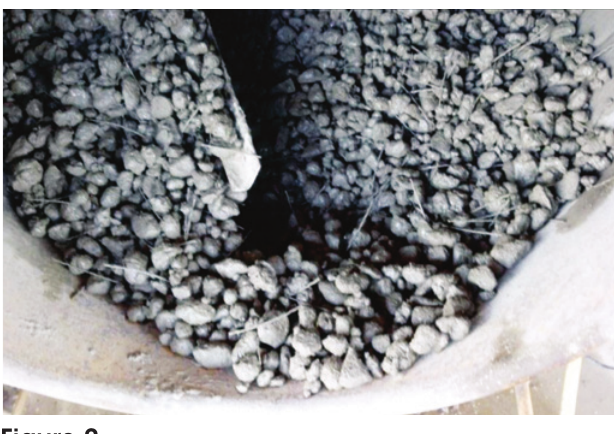
Appearance of the pervious concrete in mixture